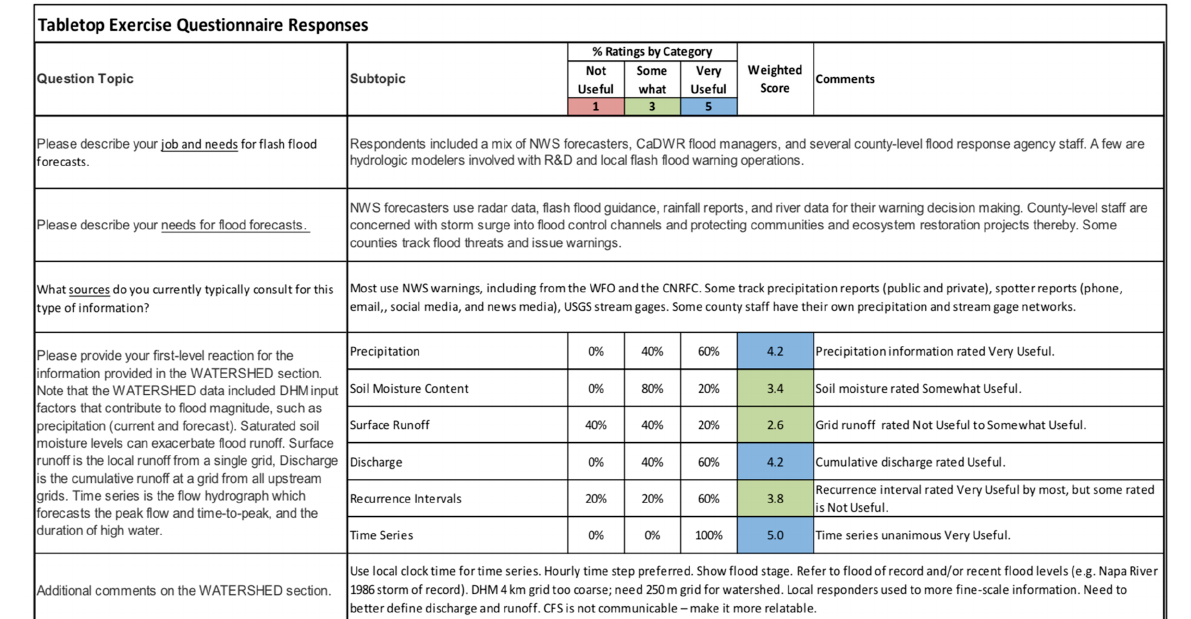
Table 2. Summary of TTE questionnaire responses for tributary flooding information.